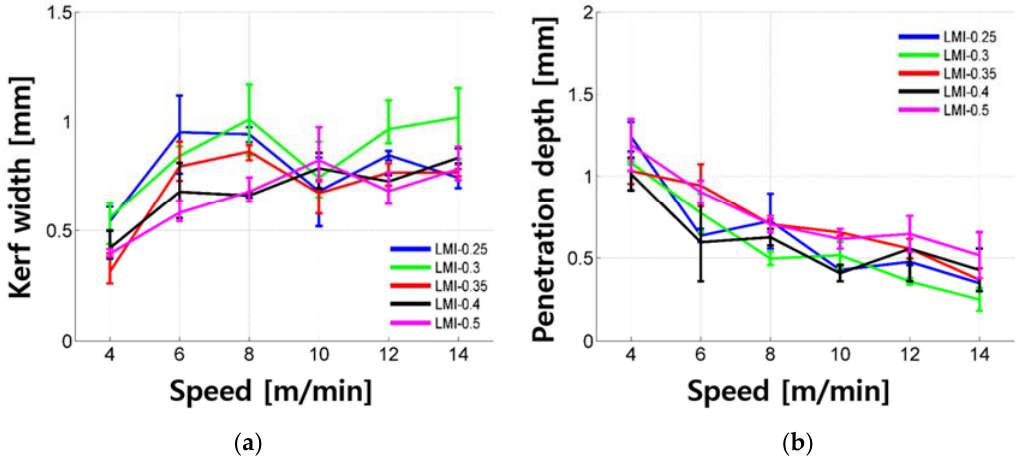
Figure 8. Kerf width ( a ) and penetration depth ( b ) vs. laser moving speed for LM1 series.